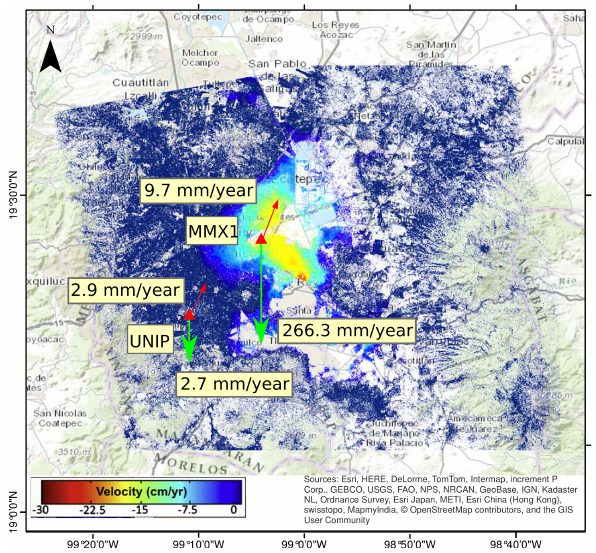
Figure 7. Horizontal (red) and vertical (green) velocity vec- tors at MMX1 and UNIP with respect to the local reference fame (SGOMRF). The color patterns represent the average subsi- dence rate derived from InSAR analysis (Chaussard et al., 2014). The three-component positional time series of UNIP and MMXI are plotted in Fig.